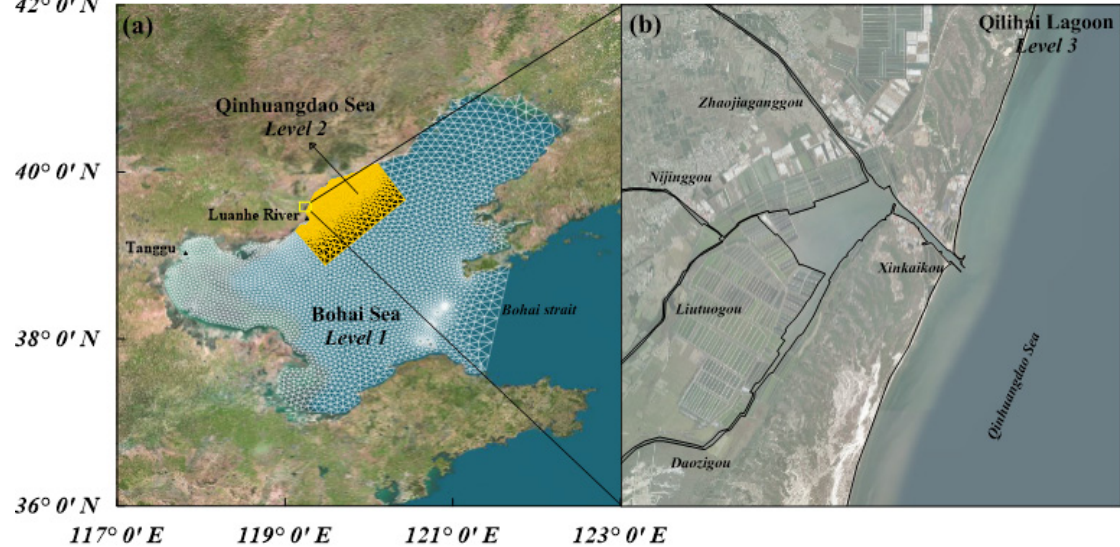
Figure 1. ( a ) Locations of QHD Sea (Level 2) and QL (Level 3) in the Bohai Sea (Level 1); ( b ) Map of QL (Level 3) with four intermittent rivers.